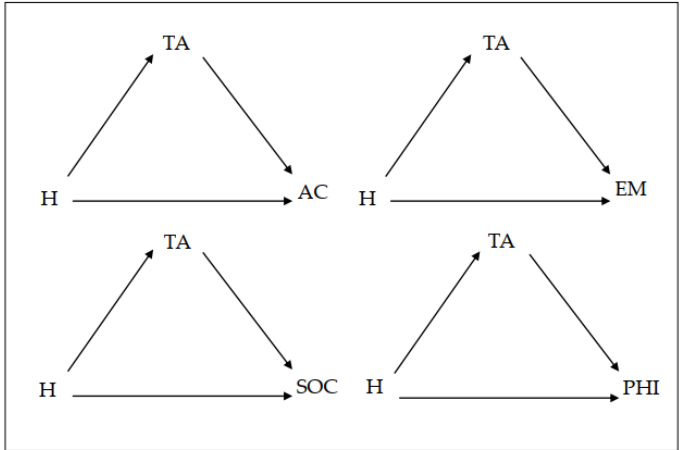
Figure 2. Mediational model for hyperactivity symptomatology; AC = Academic self-concept; EM = Emotional self-concept; SOC = Social self-concept; PHI = Physical self-concept; TA = Trait anxiety; IA= Inattention symptomatology.